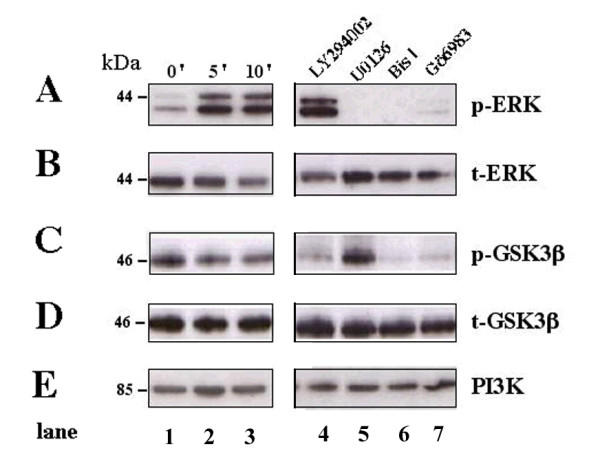
Effects of inhibitors on FGF2-mediated ERK activation A) Western blot (WB) reacted with anti-phospho-ERK after treatment with FGF2 for 0, 5, 10 min (lanes 1–3) and after inhibitors LY294002 (to block PI3K), U0126 (to block MEK), and Bis I and Gö6983 (to block PKC) (lanes 4–7, respectively). B) WB reacted with anti-total ERK antibody. (C) WB reacted with anti-phospho-GSK3β. D) WB reacted with anti-GSK3β. E) WB reacted with anti-PI3K antibody. The same WB was used in each experiment after stripping, reblocking and incubating with new antibodies for the given protein.